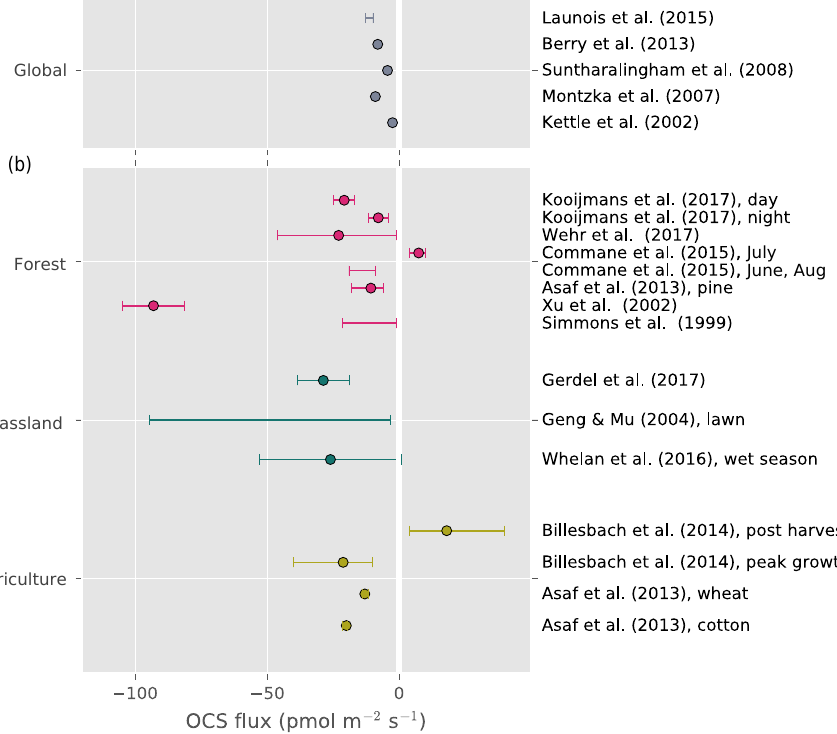
Figure 3. Top panel: global average land OCS uptake from modeling studies. Bottom panel: reported averages and ranges of whole- ecosystem, site-level OCS observations. Points represent reported averages; error bars show the uncertainty around the average or the range of observed fluxes where no meaningful average was reported.